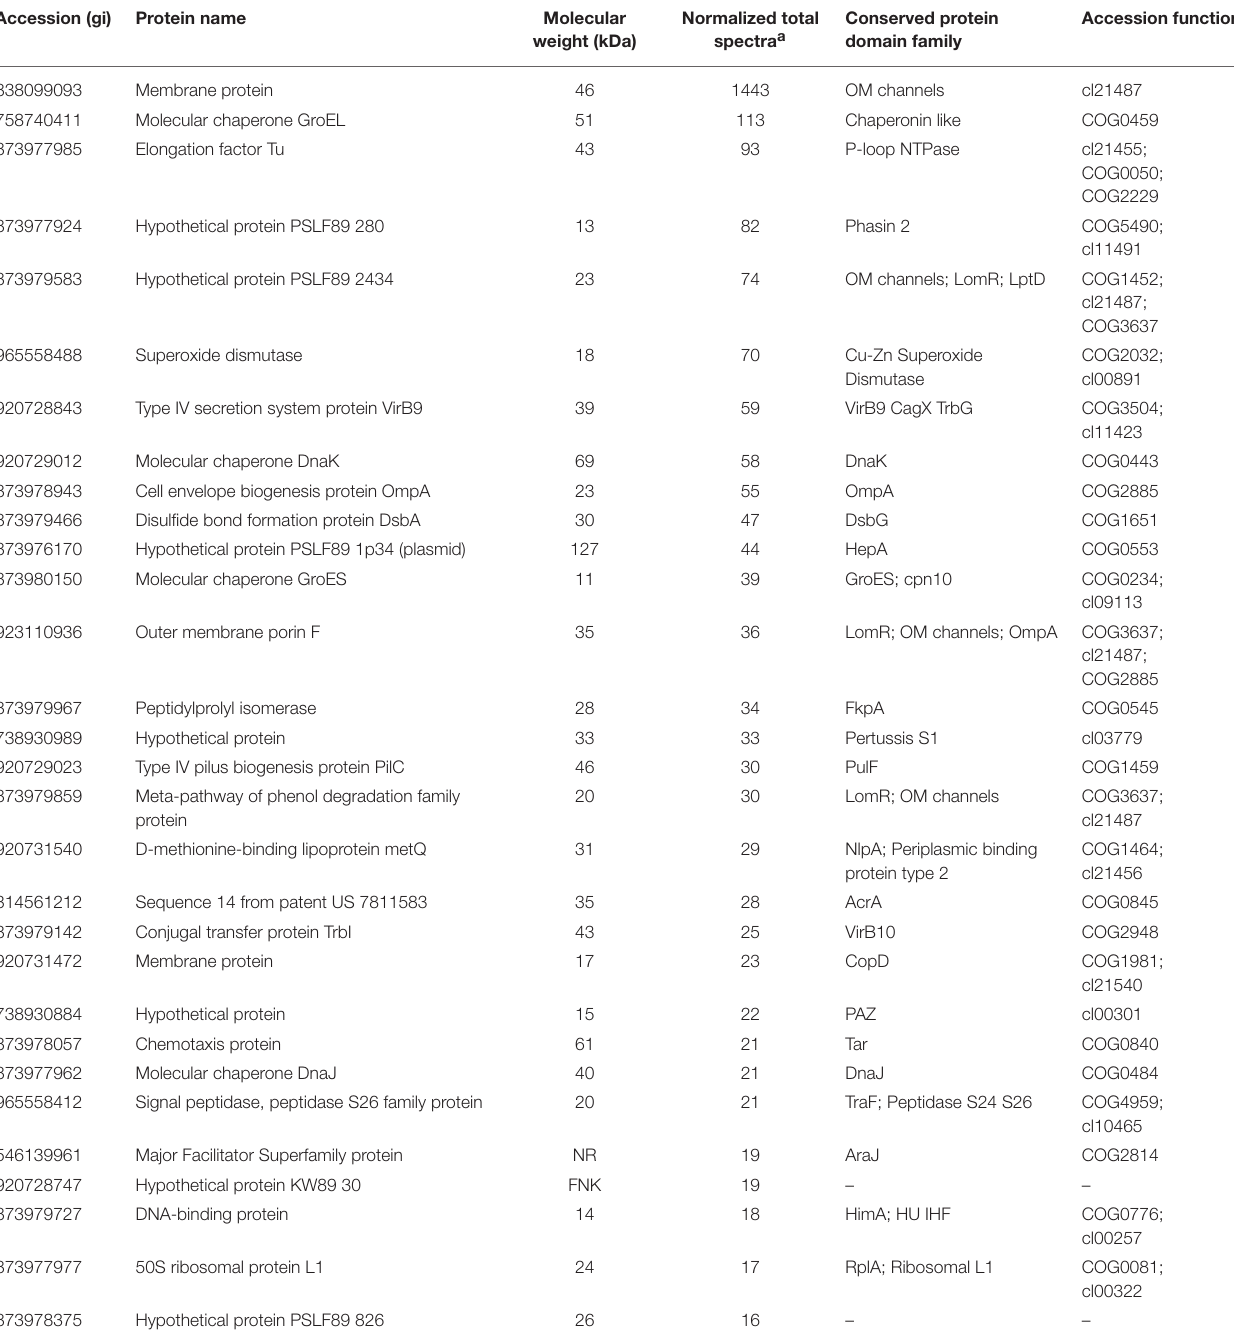
TABLE 1 | Most abundant proteins identified from P. salmonis LF-89 type strain membrane